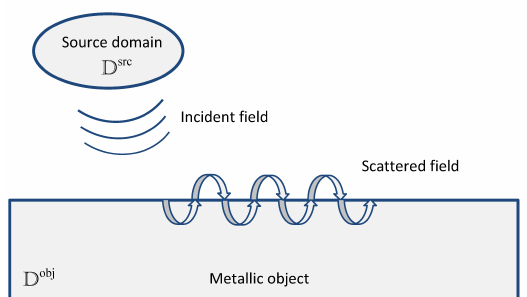
Figure 1: A metallic object illuminated by electromagnetic waves. The object occupies the object domain D obj . The sources are located in the source domain D src